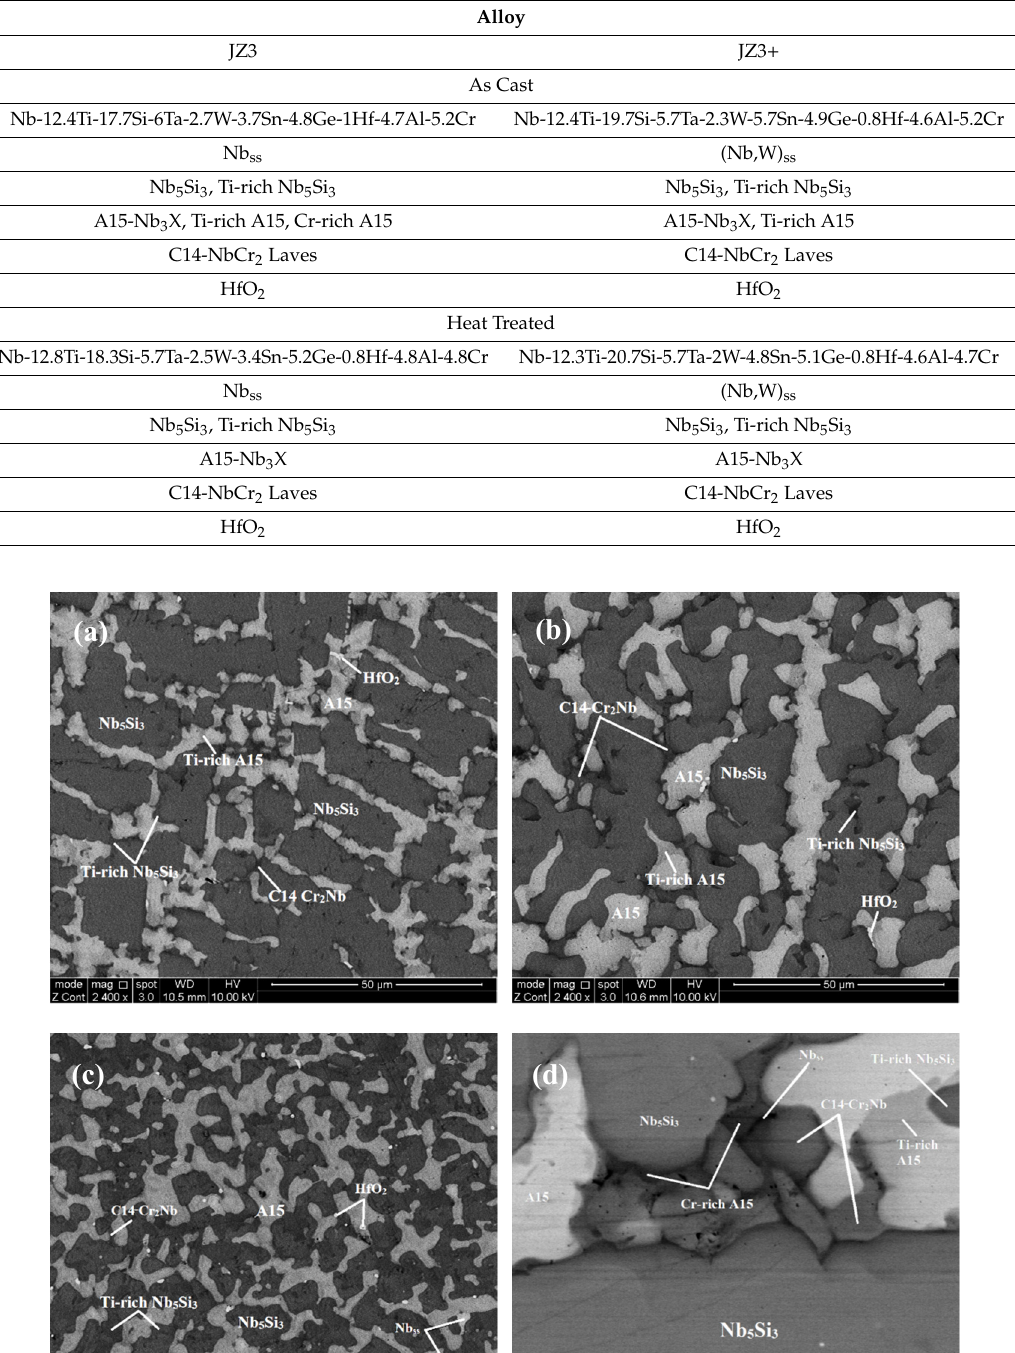
Table 2. Average chemical compositions (at.%) and summary of phases in as cast and heat treated alloys JZ3 and JZ3 + .